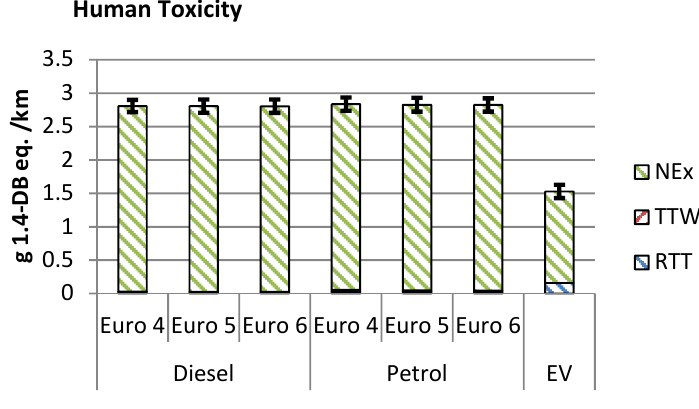
Figure 7. Human Toxicity impacts.